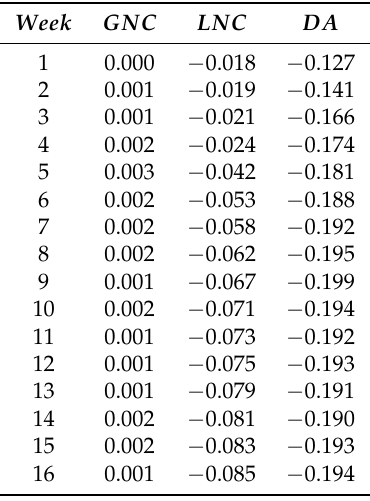
Table 3. Clustering based sampling and cross-sectional